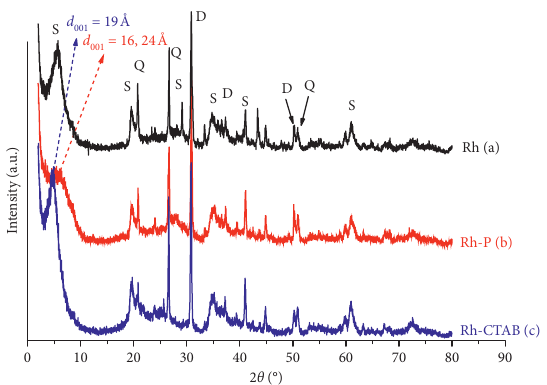
Figure 1: XRD patterns of Rh (a), Rh-P (b), and Rh-CTAB (c).